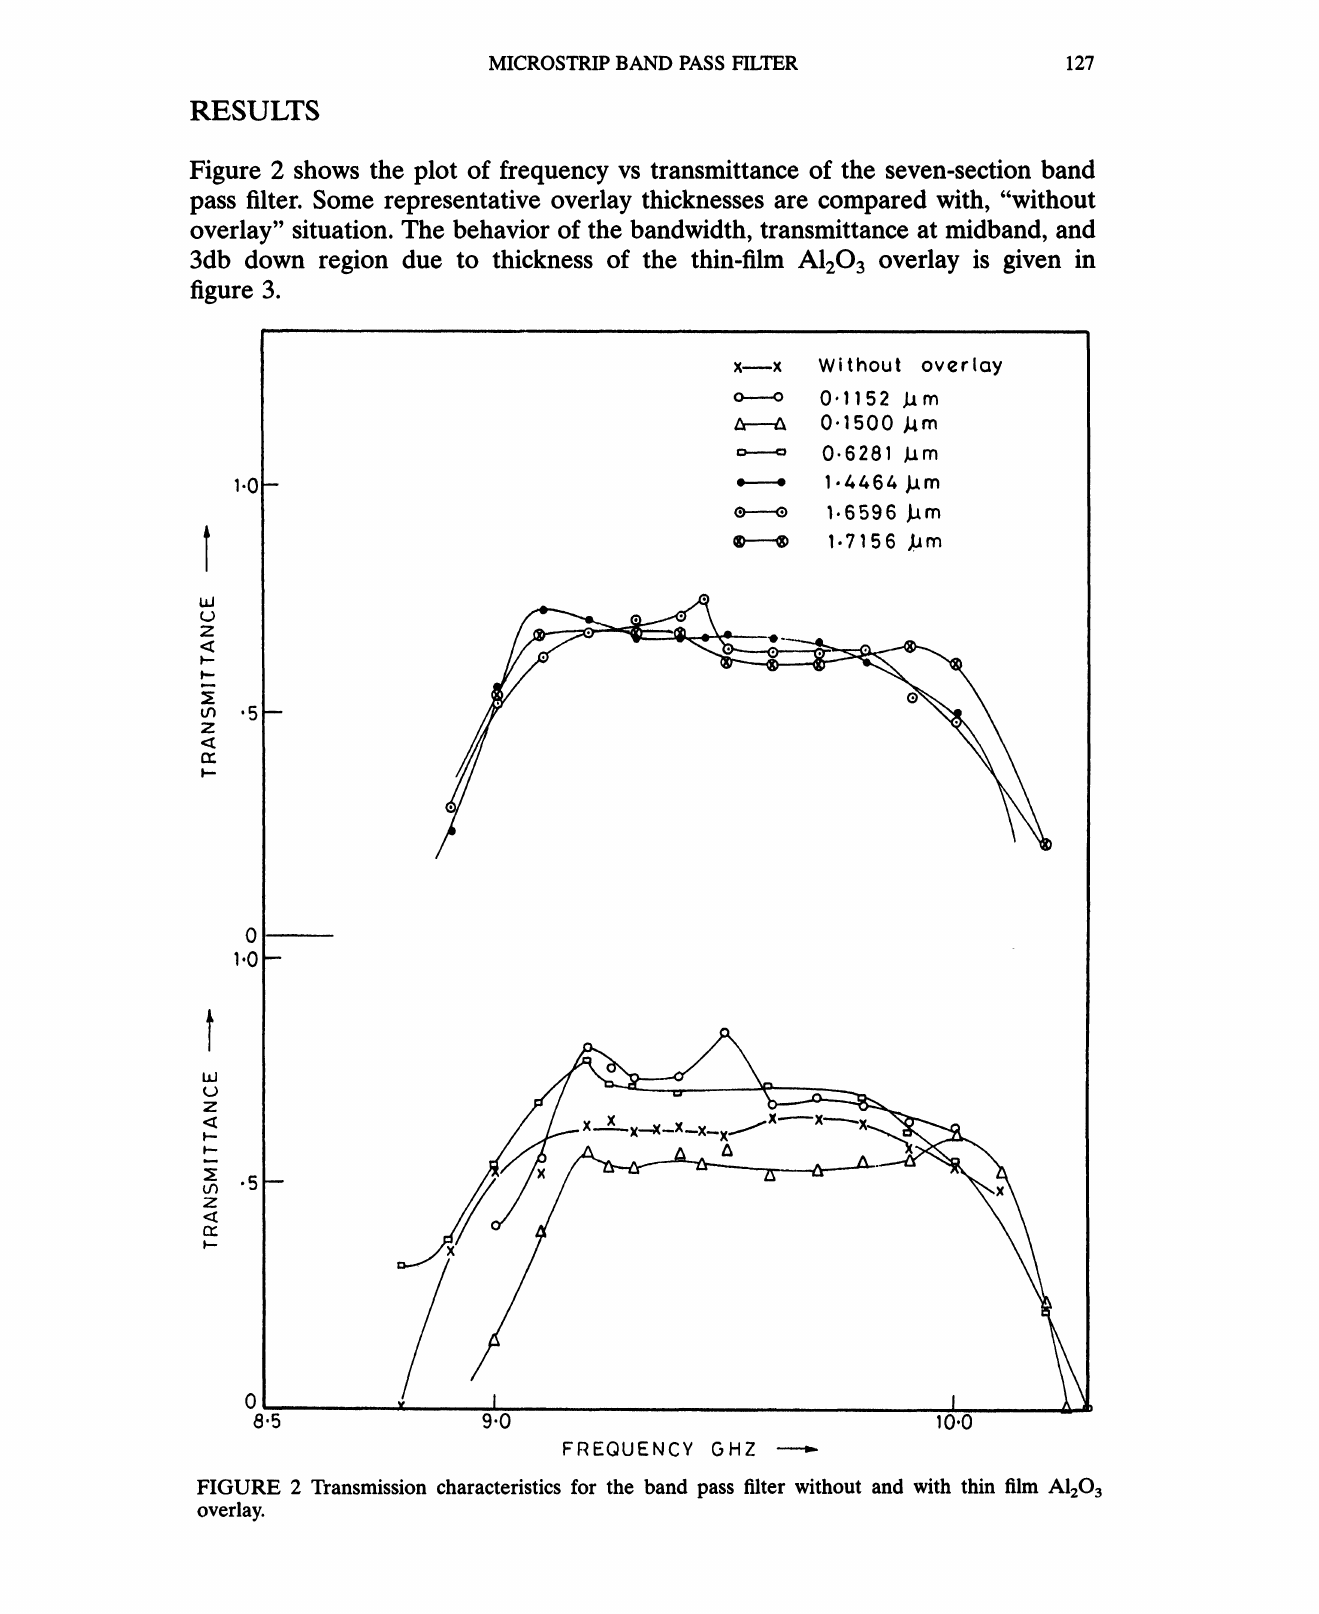
FIGURE 2 Transmission characteristics for the band pass filter without and with thin film AI20